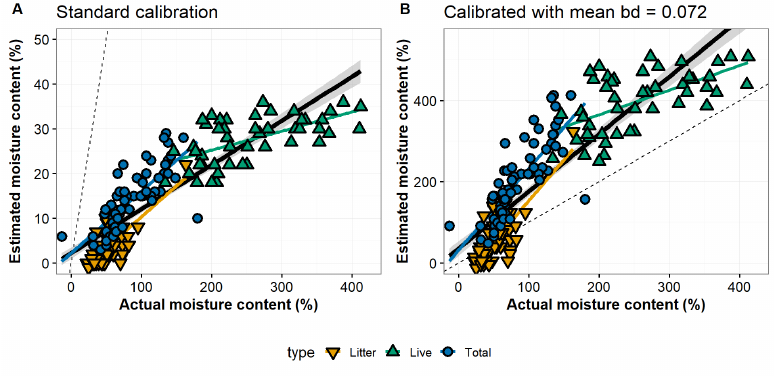
Figure A2. ( A ) Standard calibration of the DMM600, which returns volumetric water content, against actual, oven-dried metric water content of sampled grassland fuels. ( B ) Campbell Scientific’s recommended procedure for ensuring the DMM600 reports WC instead of the default VWC is to divide the coefficients in Equation (2) by sample bulk density (0.072 g/cm 3 , Figure A3) substantially overpredicts grassland fuel moisture content. Adjustments are made in Equation (3) and Figure